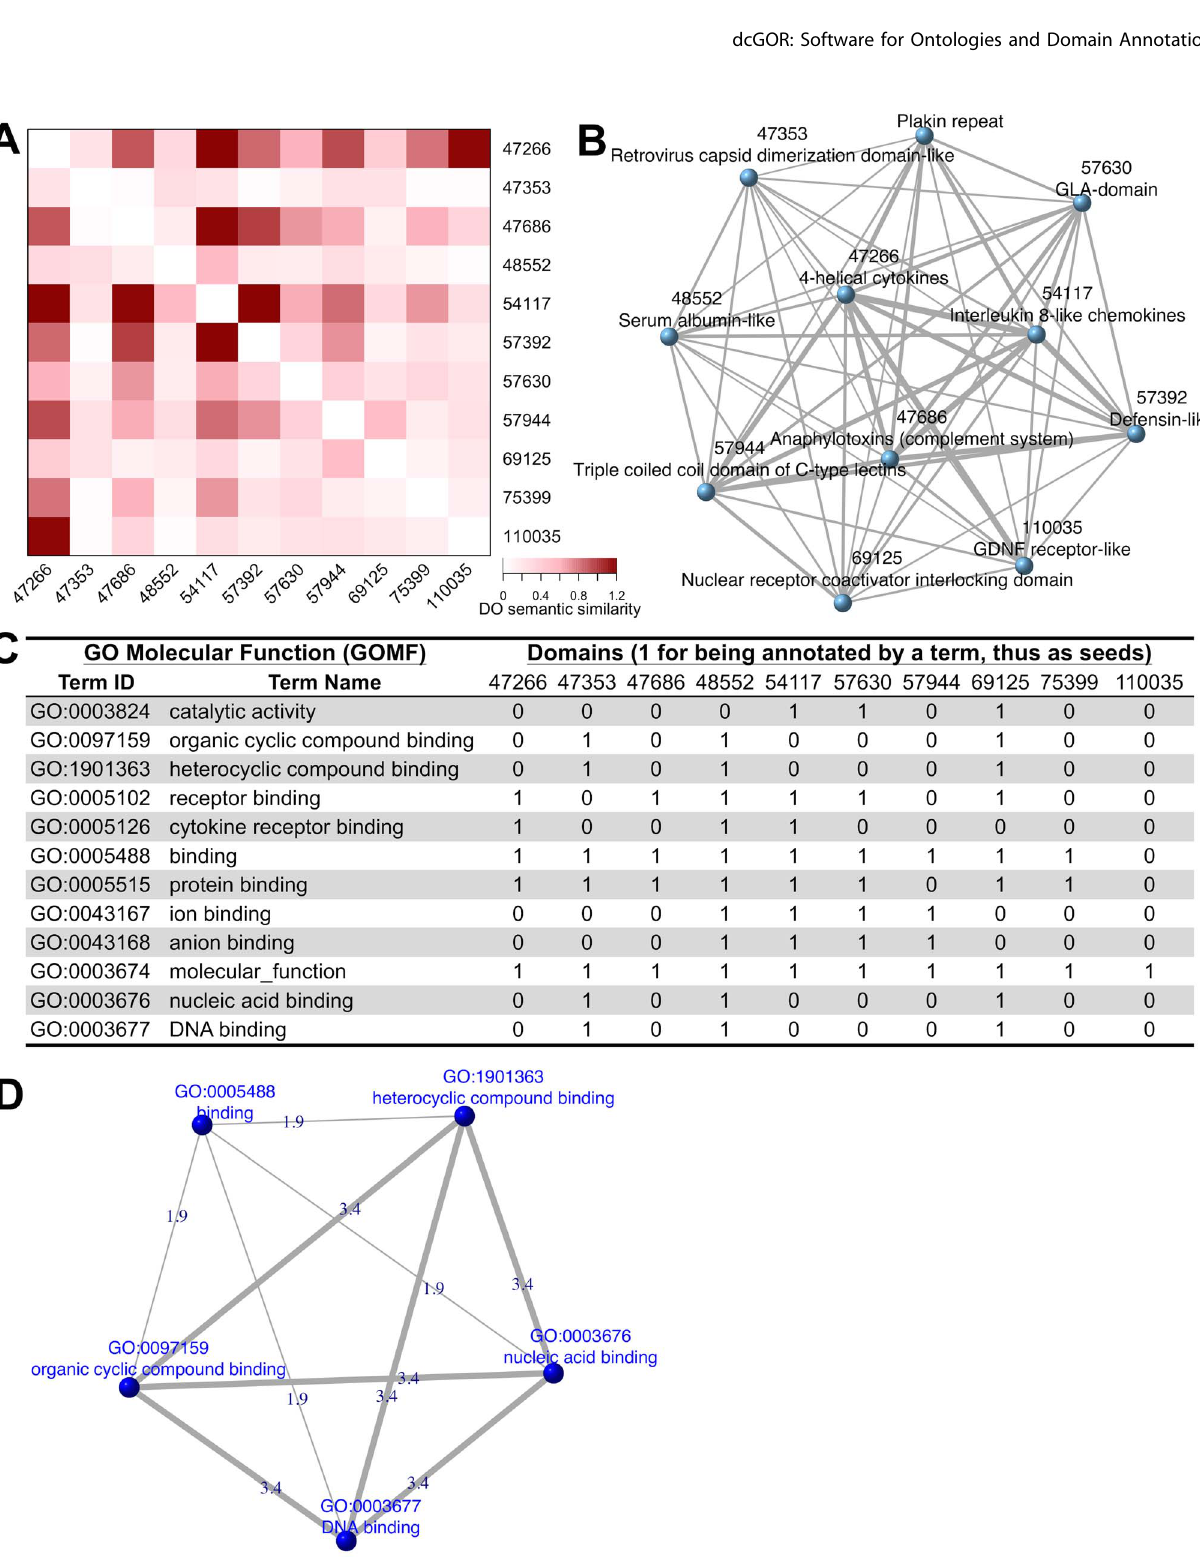
PLOS Computational Biology |